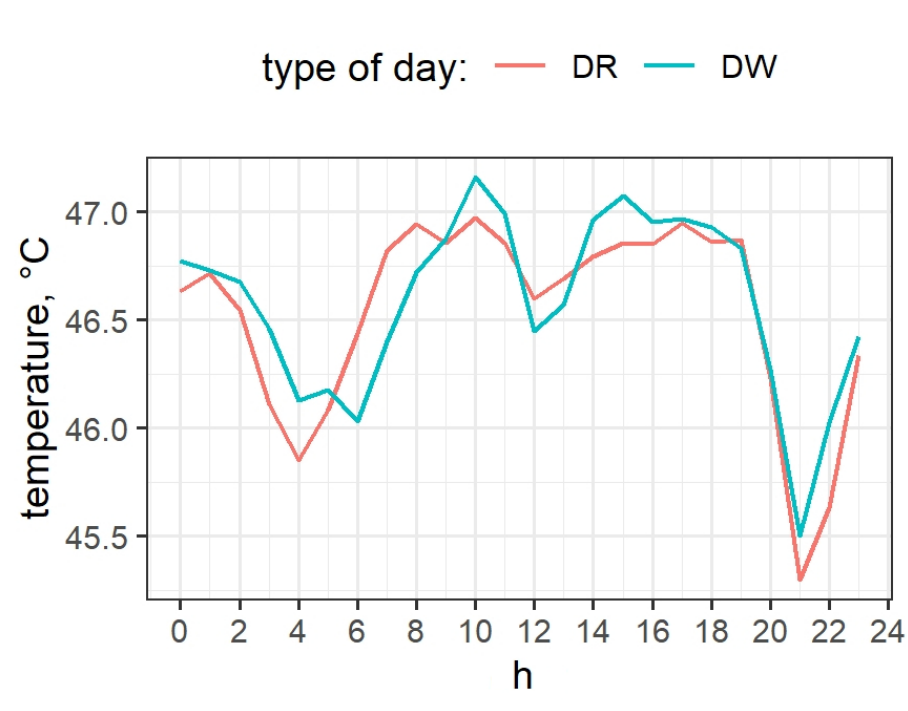
Figure 5. Hourly profile of average temperature of circulation for working day (DR) and week- ends (DW)